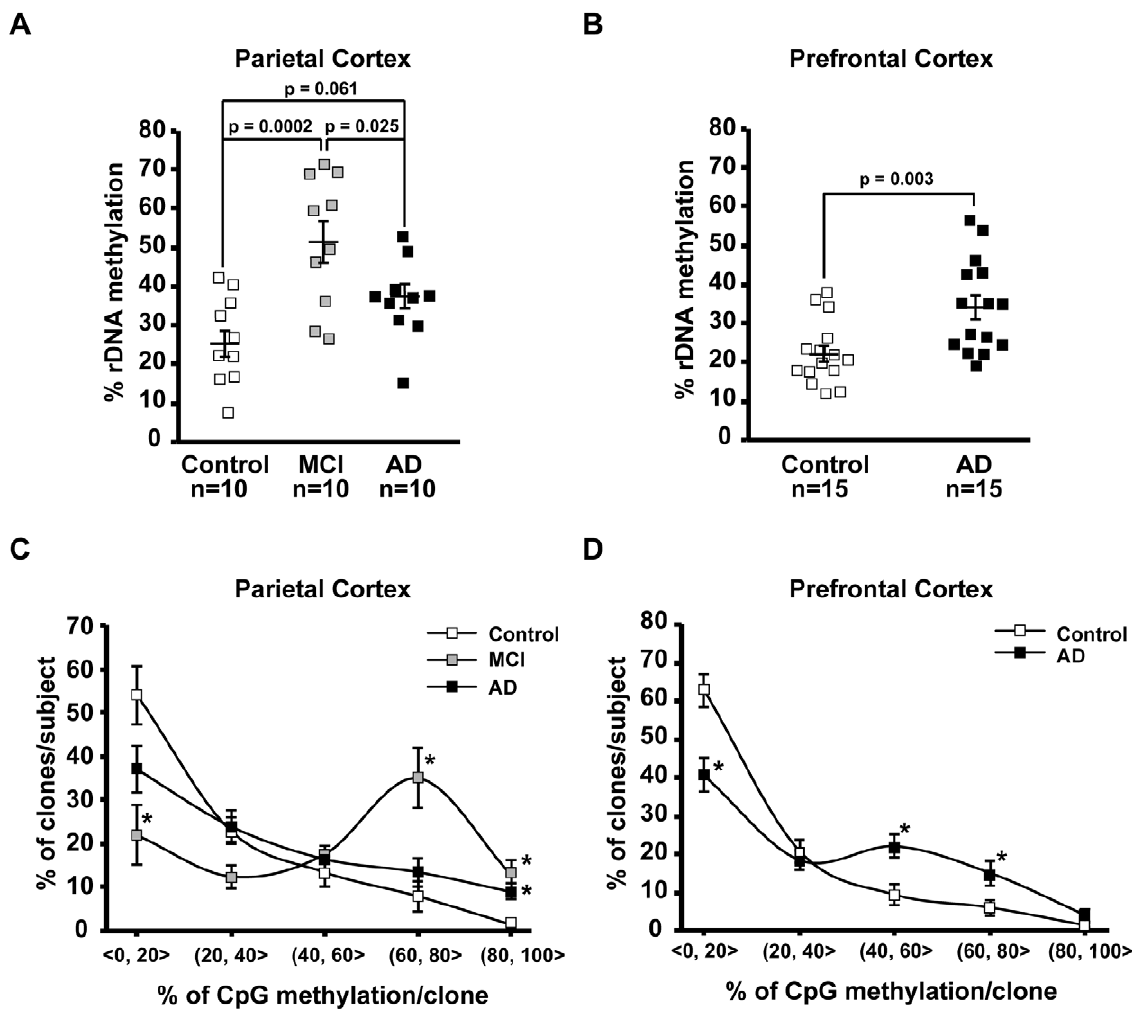
Figure 2. Effects of MCI and AD on mC content in the rDNA promoter. A–B , Average % mC in the rDNA promoter (% rDNA methylation) in the parietal- (A), and the prefrontal cortex (B). Individual values are depicted by squares; mean values are indicated by the lines intersecting the error bars (SEM); p values and number of analyzed cases (n) are indicated. In the AD-affected prefrontal cortex, the rDNA promoter is hypermethylated. C– D , The distribution of differentially methylated rDNA promoter clones is affected by MCI and AD. For each sample, % rDNA clones were determined within 5 ranges of mC content; a range definition ‘‘(20,40 . ’’ means more than 20 and less than-, or, equal to 40% mC. Mean values 6 SEM are presented for each group of subjects. The bias towards hypomethylated clones is present in controls (ANOVA, p , 0.001). That trend is disrupted or flattened in MCI or AD, respectively (two-way ANOVA, interaction between mC range and diagnosis, p , 0.001); *, p , 0.05 for post-hoc comparisons against in-range